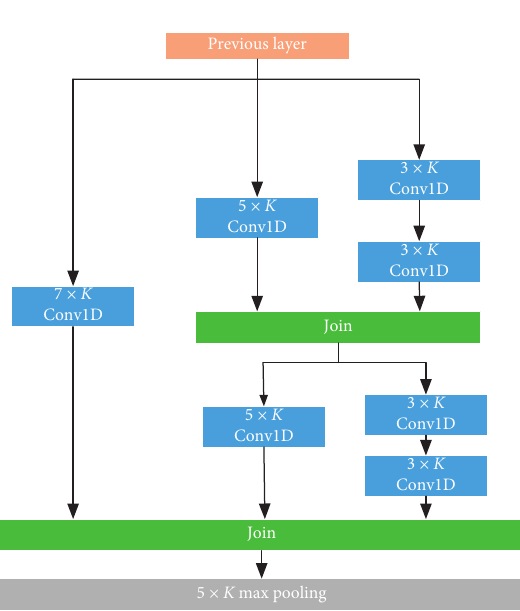
Figure 4: 1-D parallel